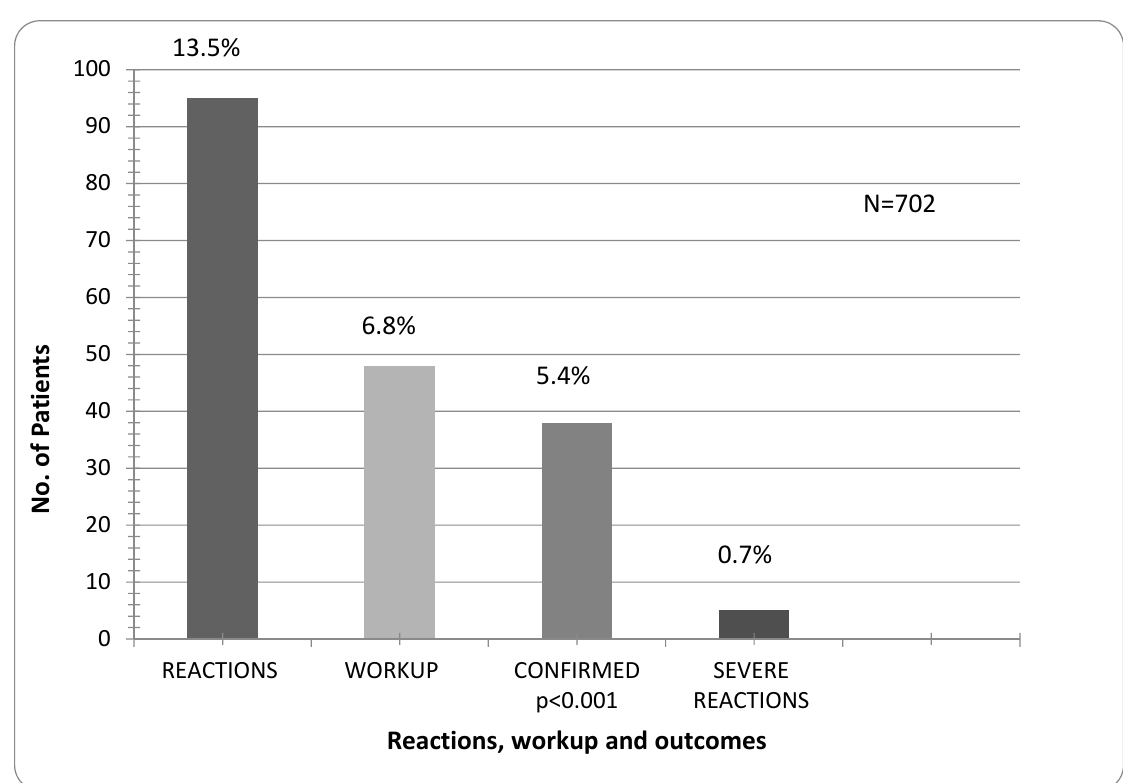
Figure 1. Prevalence of all reactions, allergy workup, confirmed allergy and severe